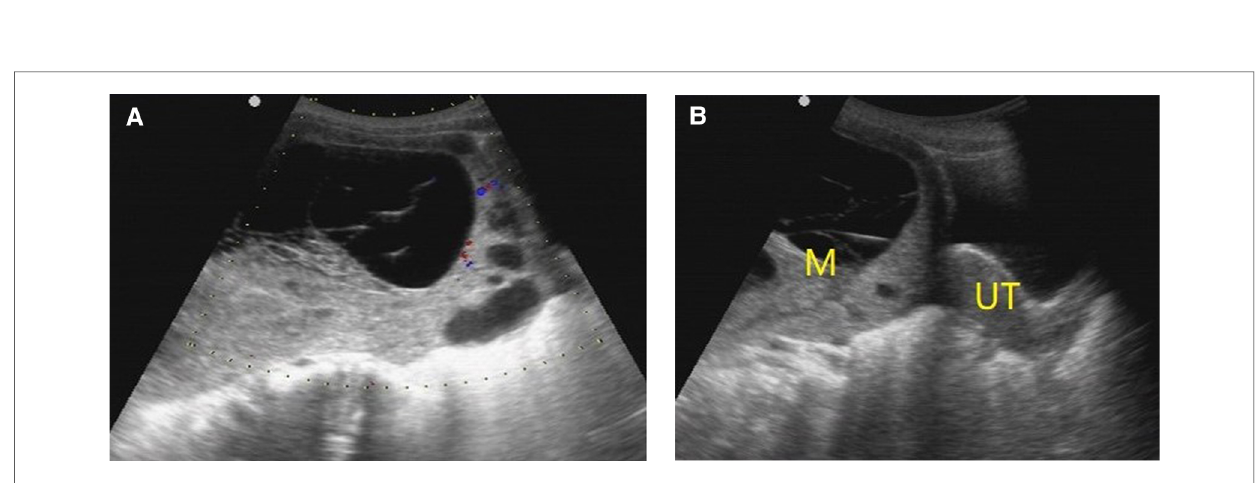
FIGURE 4 O-RADS 4, pathology: yolk sac tumor. ( A ) Multilocular cyst, solid elements, color score 2; ( B ) The mass was located above the uterus. M, mass; UT,